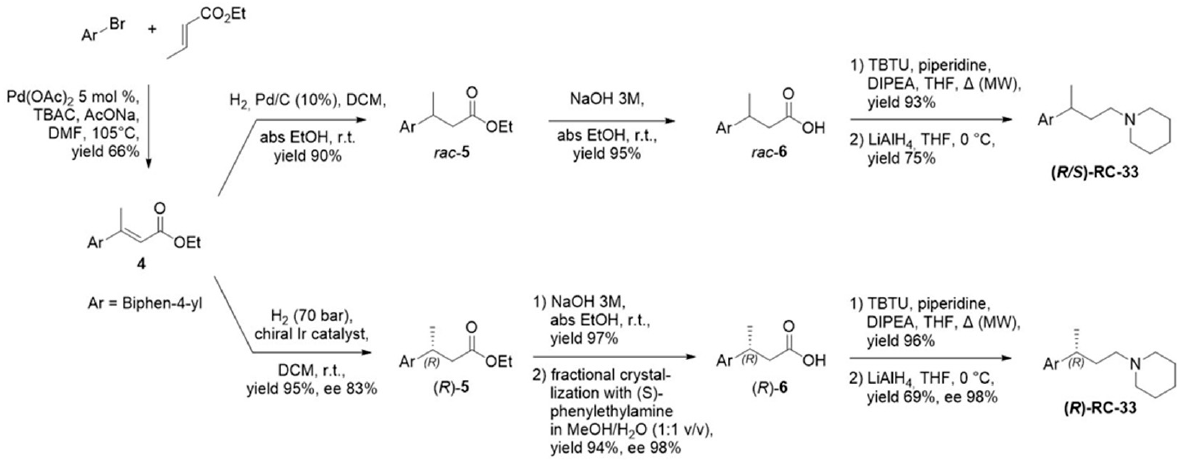
Scheme 1. Schematic synthesis procedures of racemic and enantiomeric RC33.